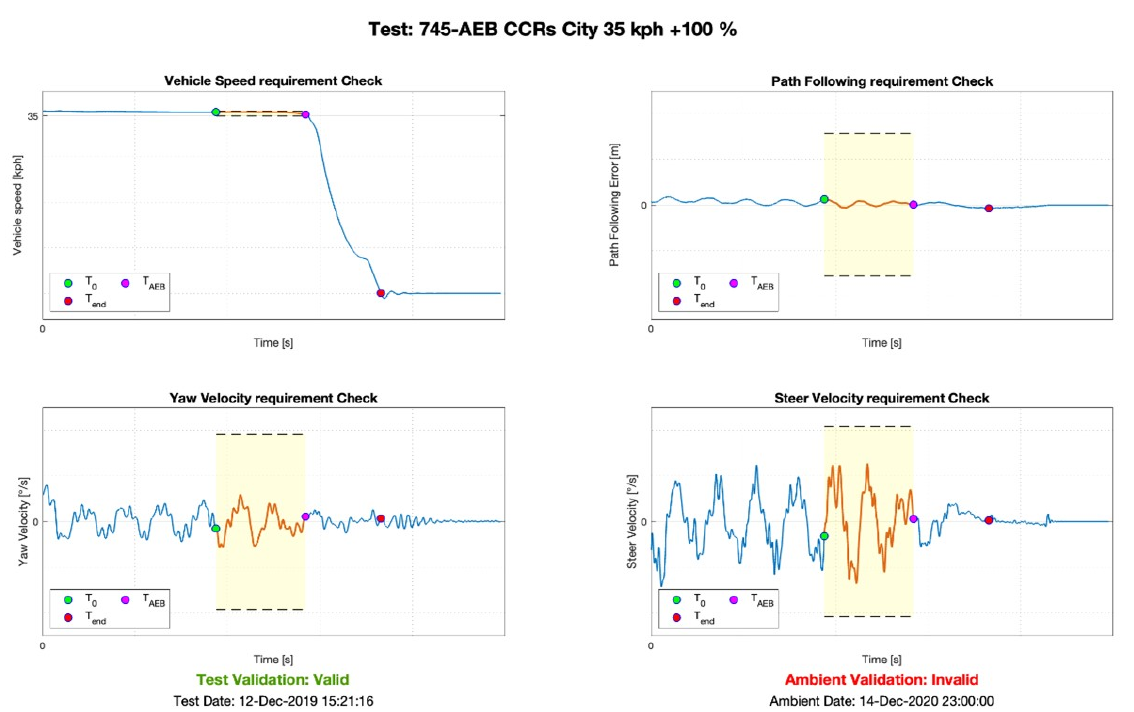
Figure 19. Post-processing results for a valid test CCRs.